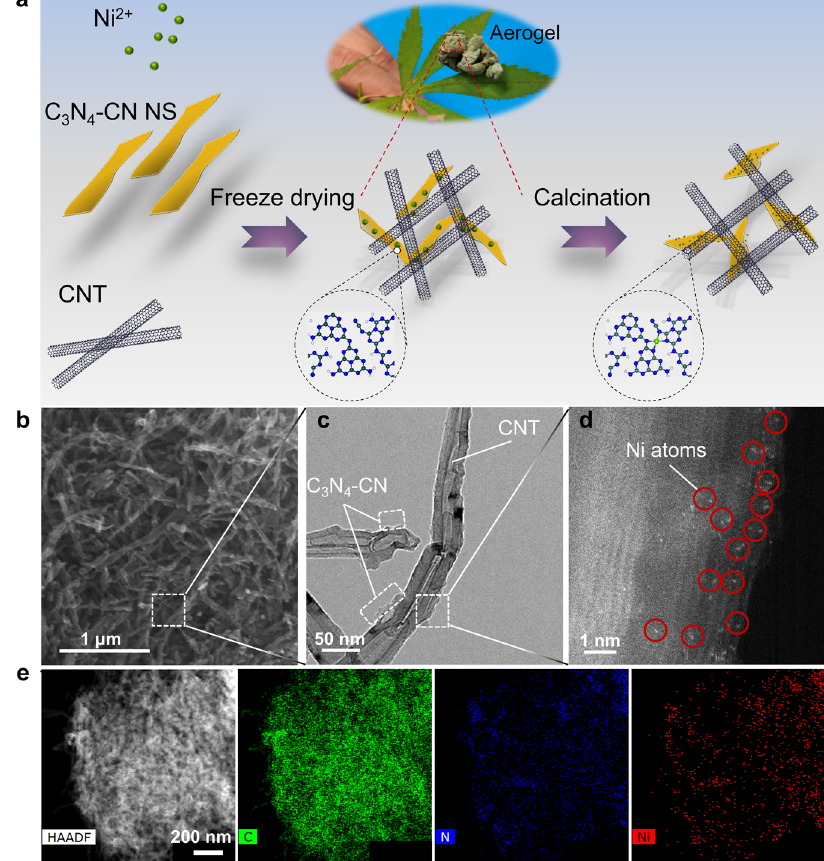
Fig. 2 | Physical characterization of Ni@C 3 N 4 -CN. a Schematic illustration of the preparation. b SEM image. c HRTEM image. d AC HAADF-STEM image. e EDS mapping